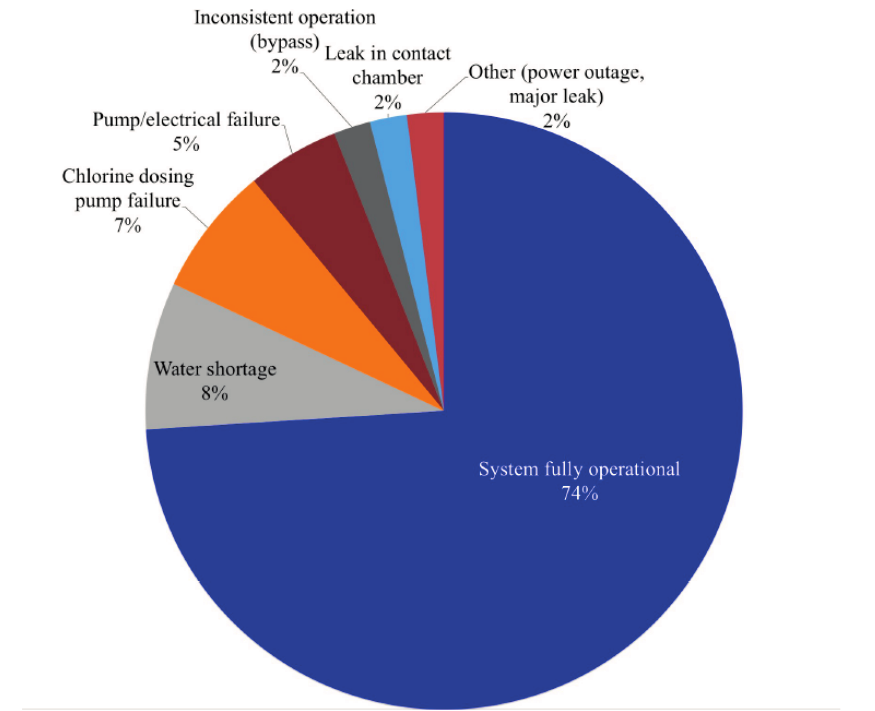
Figure 2. Functionality of water treatment systems at ten health centers in rural Rwanda, March 2012–December